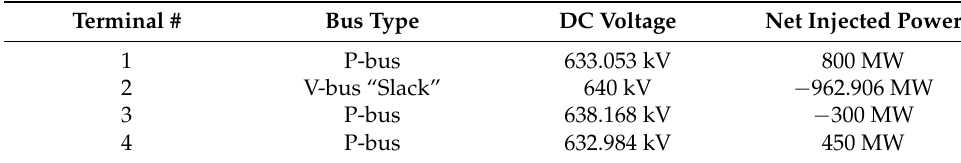
Table 2. Power flow calculation of the MTDC